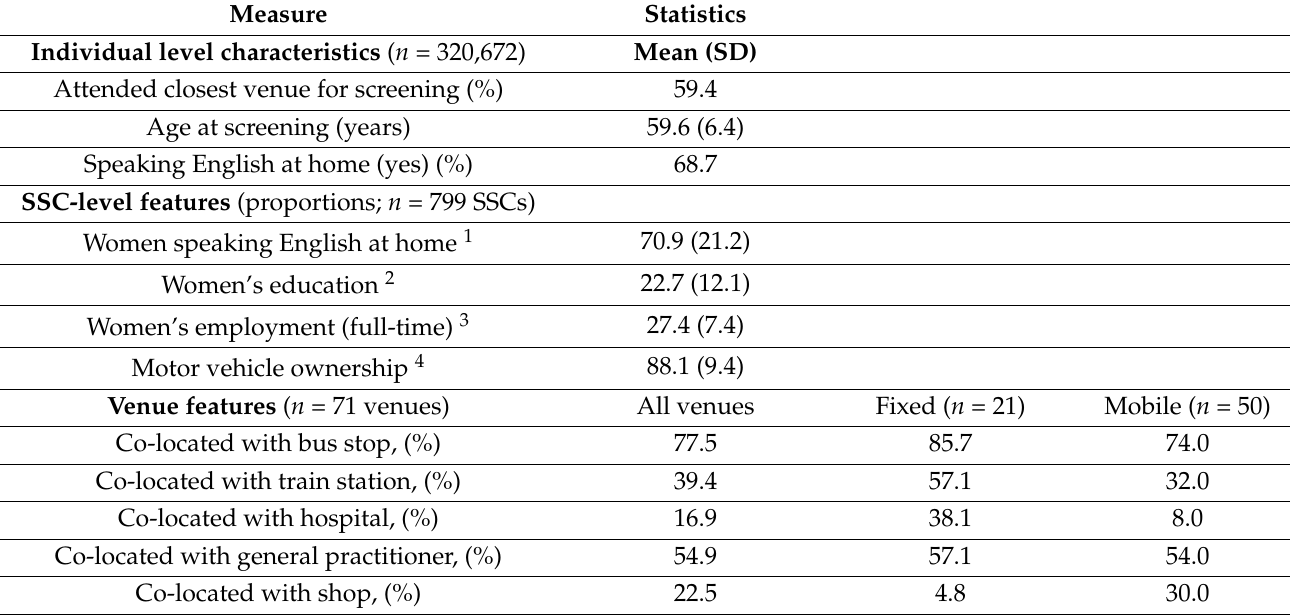
Table 1. Descriptive statistics for the analytic dataset and distribution of environmental